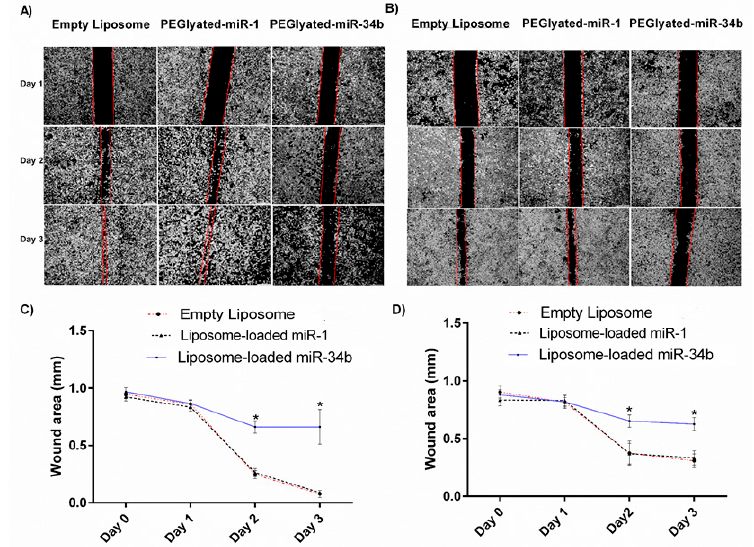
Figure 3. The influence of miR-34b overexpression in wound healing potential of thyroid carcinoma cells. The migration capacity of anaplastic thyroid carcinoma (8505C cells) significantly decreased after day 3 of transfection with miR-34b ( A ) and wound healed faster in liposome-loaded miR-1 and empty liposome transfected control groups in comparison to liposome-loaded miR-34b transfected group ( C ). A similar trend was observed in anaplastic thyroid carcinoma cells - BHT-101 ( B ). The wound healed slower in liposome-loaded miR-34b treated compared to liposome-loaded miR-1 and empty liposome transfected control group ( D ). Wound areas of all experimental cell types on different days (day 0 to day 3) were recorded from three independent measurements and shown as mean ± SD. Level of significance, * p < 0.05, when compared to the control